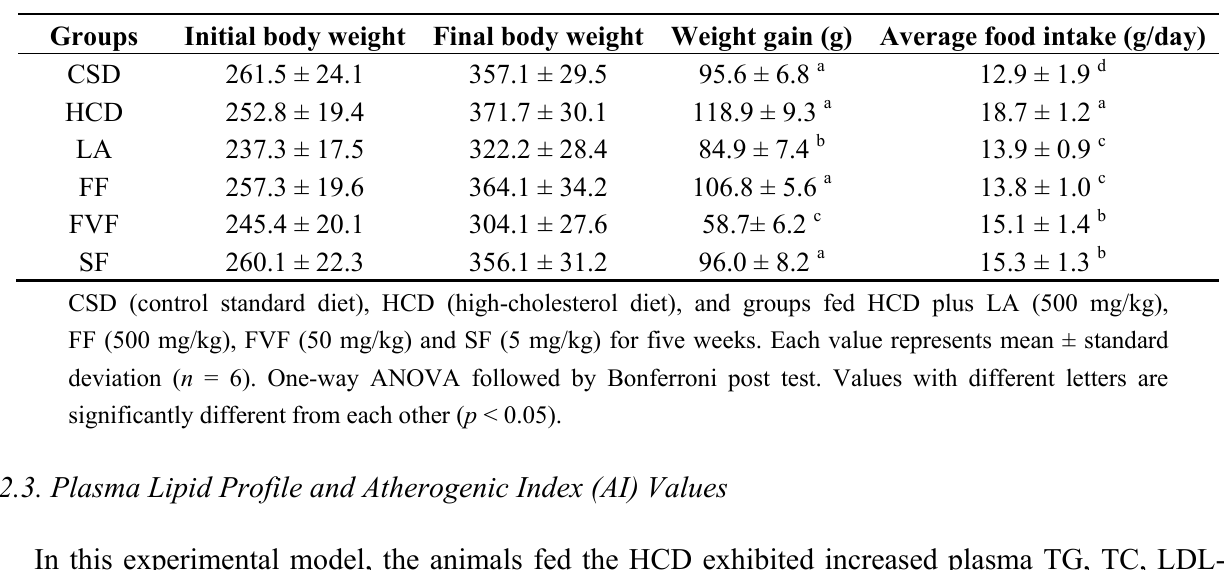
Table 2. Weight gain and average food intake in experimental animals.